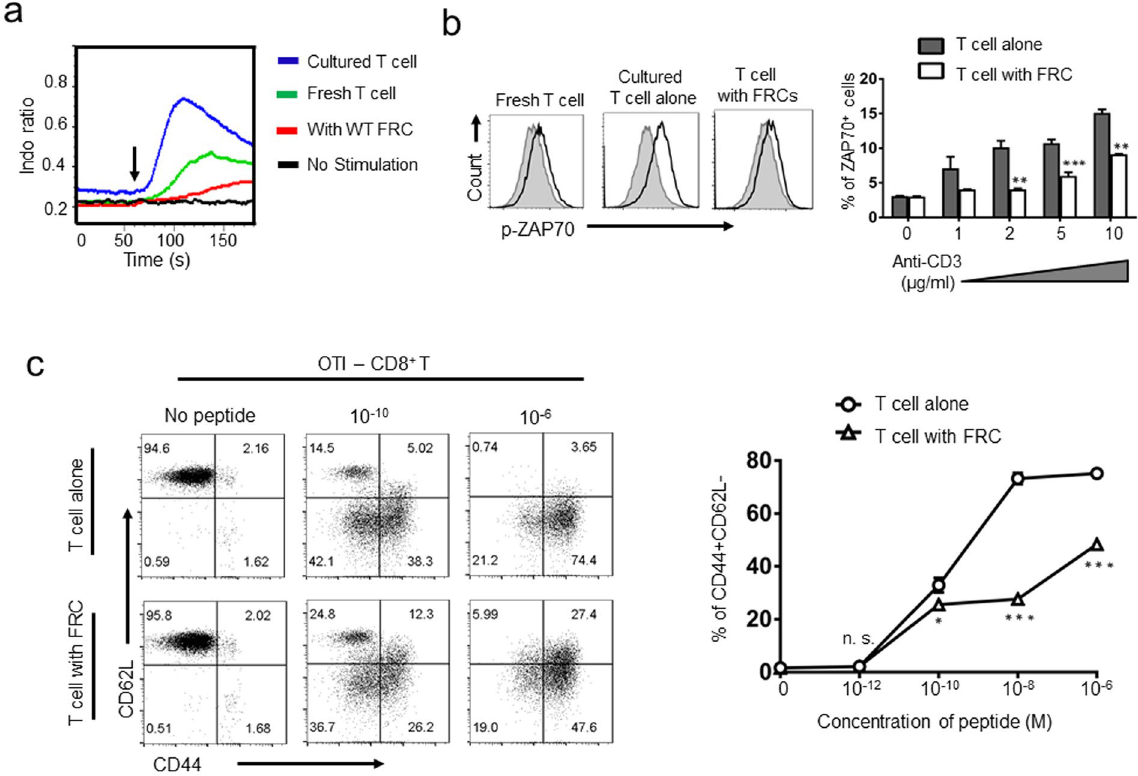
Figure 2. FRCs suppress antigen-specific and non-antigen-specific T cell activation and subsequent effector cytokine production. ( a ) Naïve T cells, either immediately following isolation from LNs (green line), cultured overnight in the absence of FRCs (blue), or in the presence of FRCs (red), respectively, were first loaded with 5 µ M of Indo 1-AM dye, labeled with biotinylated anti-CD3 (1 μ M) for 15 min, and subsequently stimulated by addition of Streptavidin (10 mg/ml) to trigger TCR-ligation. Calcium-flux was examined via Flow cytometry. Arrow indicates the addition of streptavidin. Data are representative of three independent experiments. ( b ) Following 30 min of anti-CD3 (1–10 μ g/ml) mediated stimulation, ZAP70 phosphorylation in T cells was determined via flow cytometry analysis following intracellular staining. The representative histograms of ZAP70 phosphorylation in 2 μ g/ml of anti-CD3 stimulated freshly isolated T cells (left), T cells cultured overnight alone (middle), or co-cultured with FRC (left), respectively (top row, dark lines), were compared with unstimulated controls (gray lines). ( c ) OT-I splenic cells were stimulated by varying concentrations of SIINFEKL peptide in the absence or presence of SLN-FRCs. OT-I splenic cells cultured in the absence of SIINFEKL peptide were used as non-activation control. T cell activation at 20 hrs post-stimulation was assessed as changes in CD62L and CD44 expression via flow cytometry. Data are representative of three independent experiments with three replicates each. Error bars depict mean ± SEM. * p < 0.05, ** p < 0.01, *** p < 0.001 compared with respective control (nonparametric Mann-Whitney